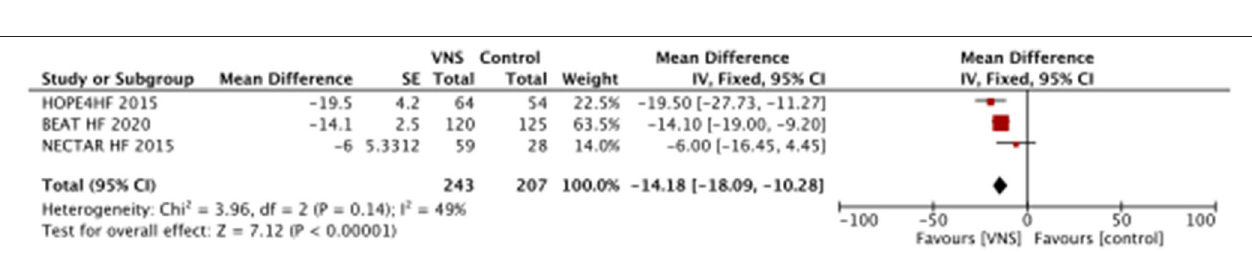
FIGURE 3 | Improvement of at least one New York Heart Association functional class during follow-up between VNS and control groups for management of chronic heart failure with reduced ejection fraction. VNS, vagus nerve stimulation.